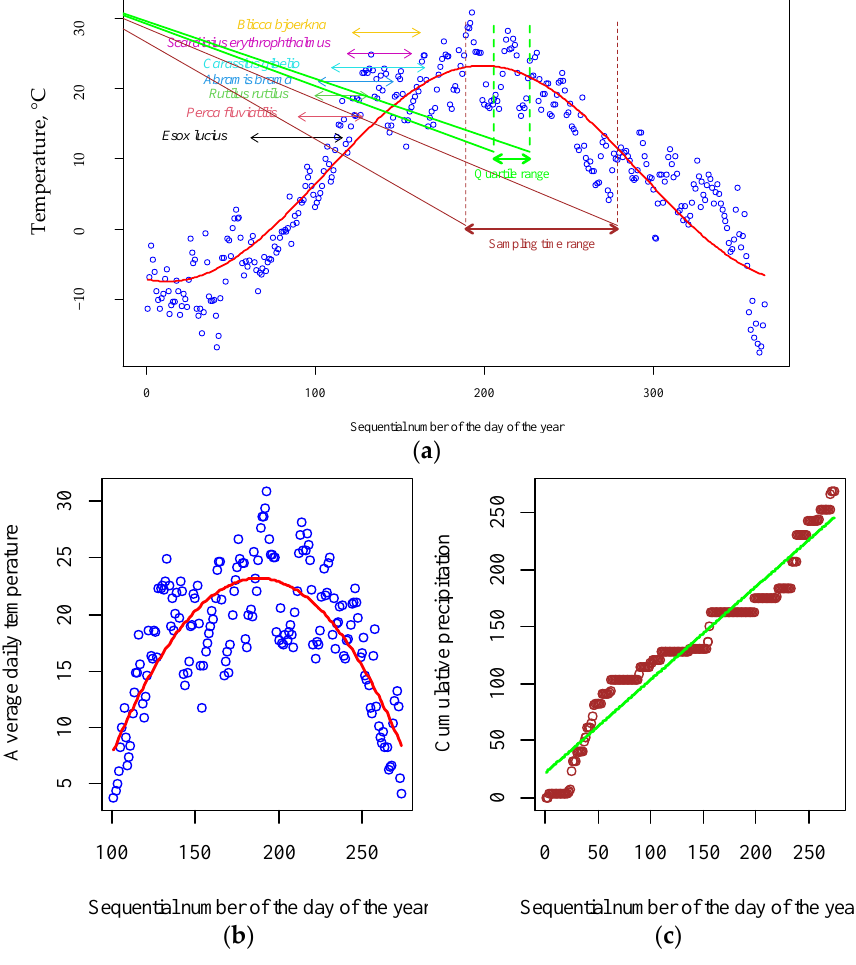
Figure 2. Seasonal course of temperatures and cumulative precipitation: ( a ) is the annual temperature pattern, the spawning time range of the dominant fish species, and the sampling time range (the quartile range indicates the range that corresponds to quartile 2 and 3, in other words, in this time range 50% of the fish collections were made); ( b ) is the average daily temperature variations (°C) from day 100 to day 275 of the year (blue circles) and the parabola that approximates the temperature trend (red line); ( c ) is the cumulative precipitation (mm) from day 1 to day 275 of the year (brown circles) and the straight line approximating the cumulative precipitation trend (green line).